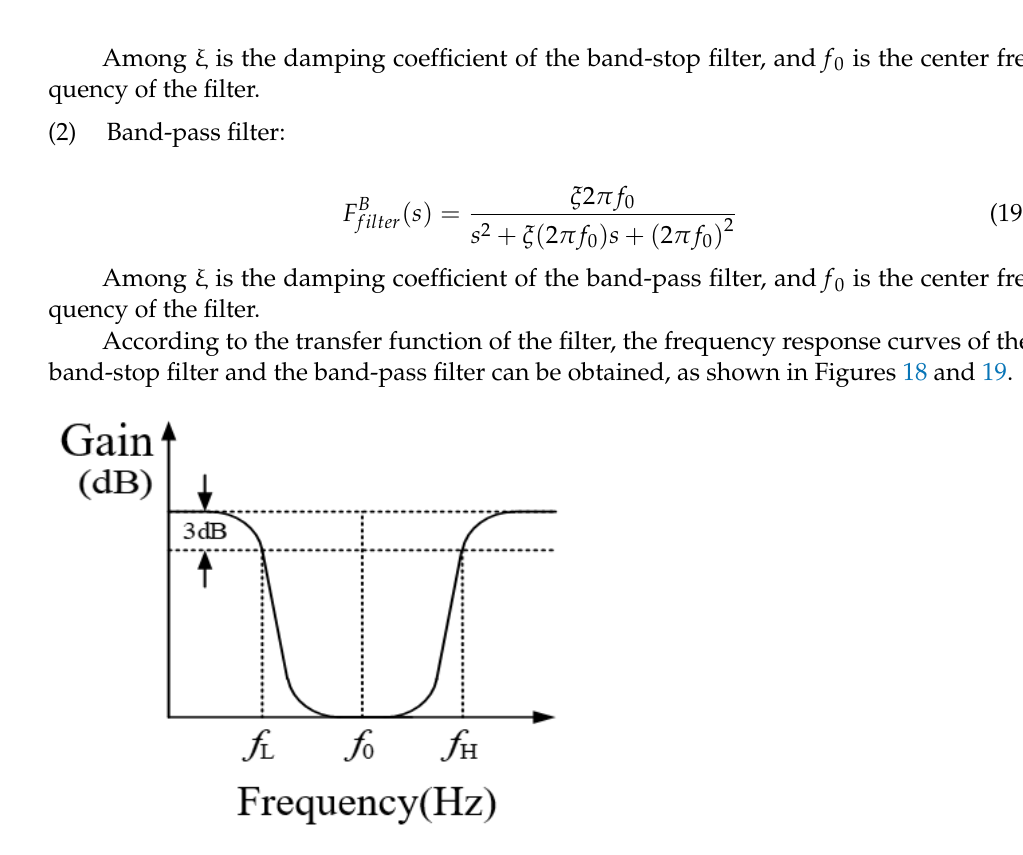
Figure 18. Filter frequency response curve of band-stop filter.